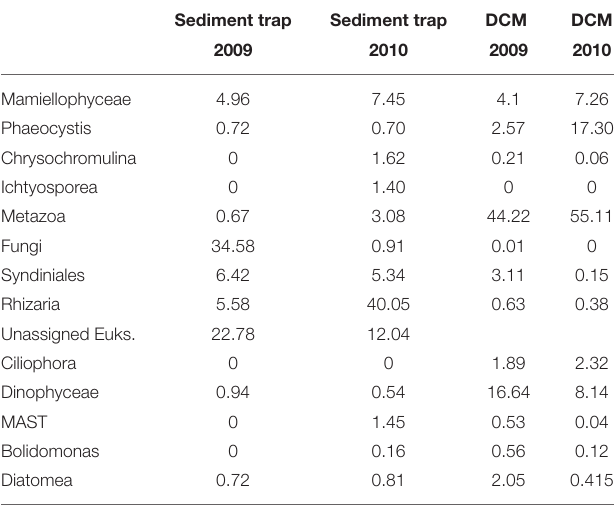
TABLE 3 | Relative sequence abundance of taxonomic groups that contribute to the abundant biosphere in the sediment trap samples and the DCM samples analyzed in this